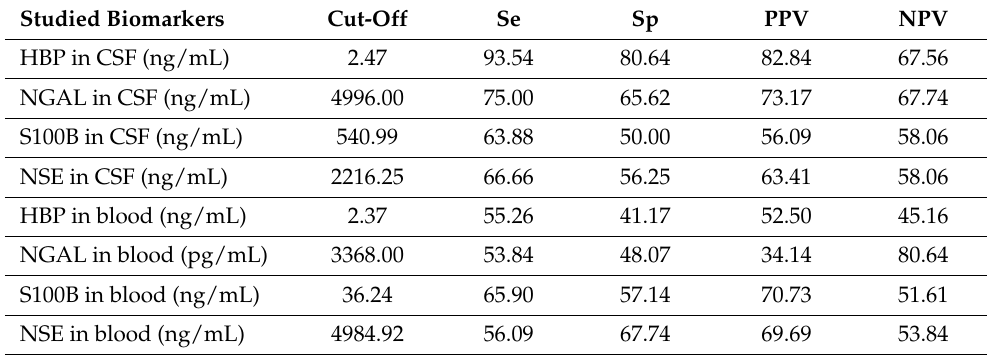
Table 7. Statistical evaluation of biomarkers (HBP, NGAL, S100B, NSE) in CSF and